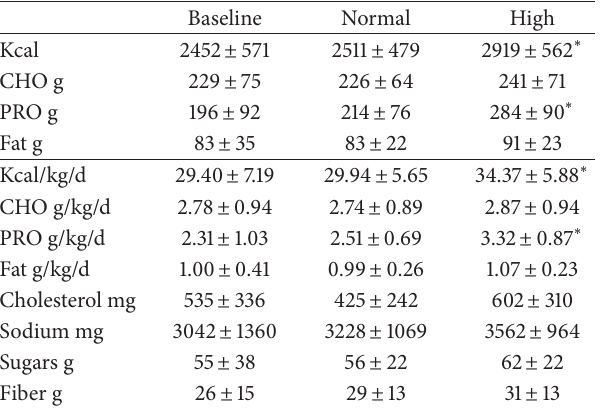
Table 2: Dietary